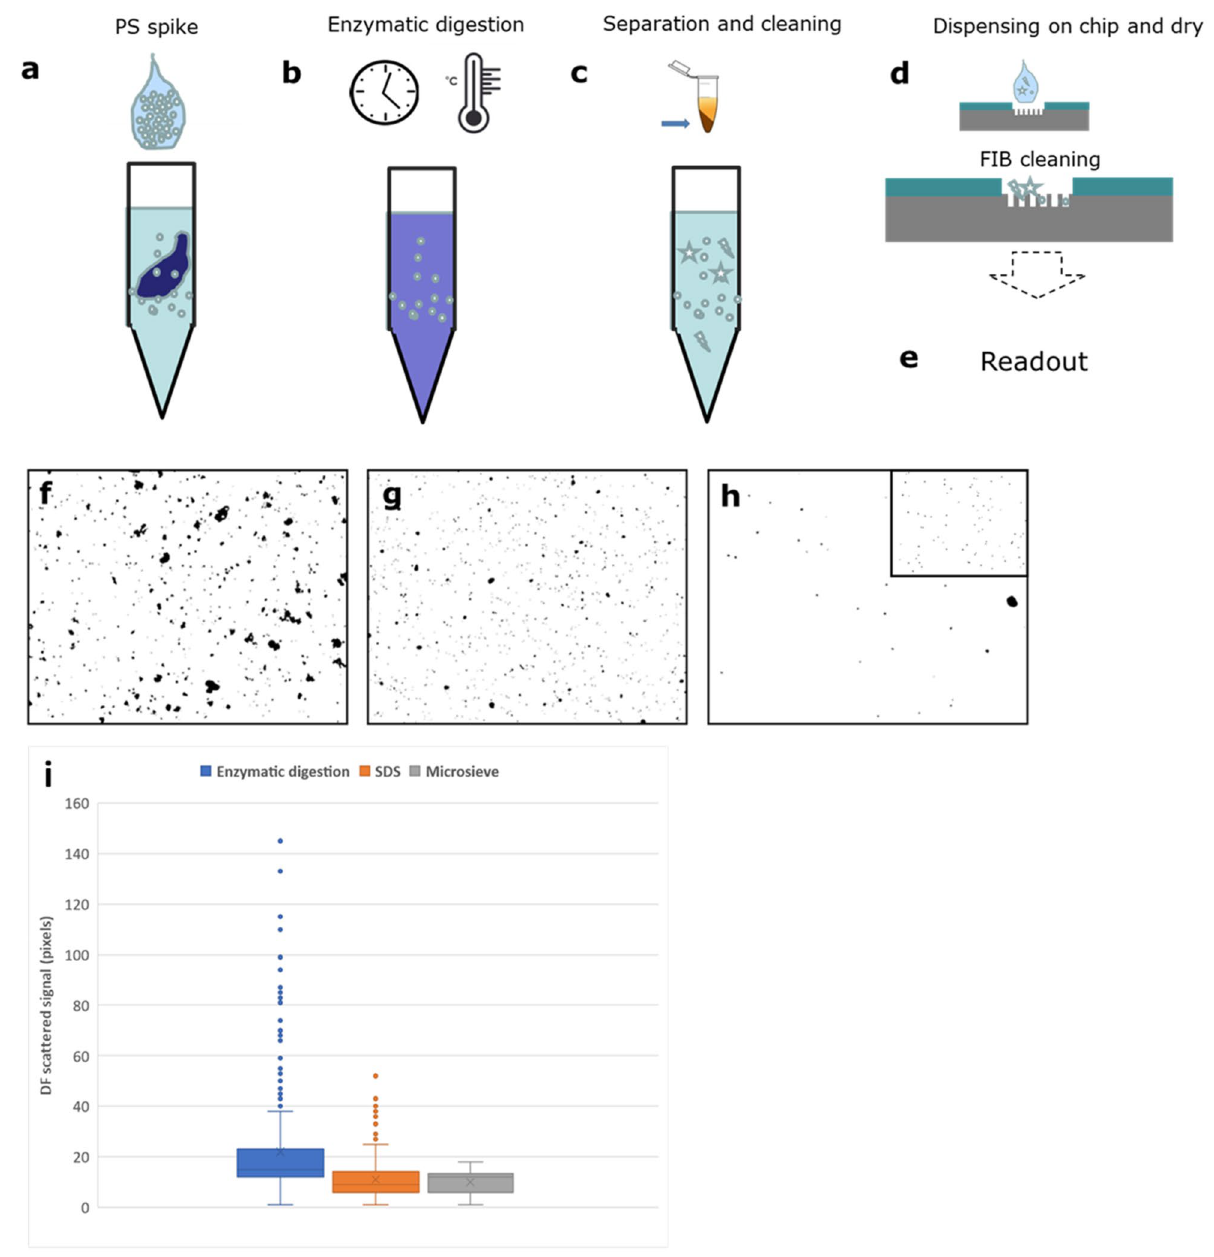
Figure 3. Schematics of the preparation method ( a ) spiking of the entire animal with nanoparticles ( b ) enzymatic digestion ( c ) separation and cleaning of the matrix ( d )–( e ) dispensing on the chip, FIB cleaning and readout (described in the next paragraphs). ( f )–( h ) Objects recognized by dark-field microscopy of samples after enzymatic digestion, after adding SDS and after filtering with micro-sieves. In the inset in ( h ) a typical dark-field signal from PS beads of 500 nm is shown. ( i ) distribution of the scattering signal of the objects by DF after each step of the sludge reference distribution obtained by spiking ultrapure water with PS-pNP (1 µm). Figure 3i shows the distribution of the scattering signal of the objects by DF after each step of the sludge purification, being the scattering signal proportional to the size. The size of the objects thus decreases after each step of the process, with a particular decrease between the enzymatic digestion and the SDS adding process. After purification, the resulting complex homogenate matrix exhibits viscosity and density suitable for homogenous drop-cast deposition as a thin film on the chip surface. The TEM images of samples extracted using the previously described method are shown in Fig. 4. The pNP size is not affected by enzymatic digestion and the subsequent cleaning steps. Focused Ion Beam selective cleaning of the biological matrix..